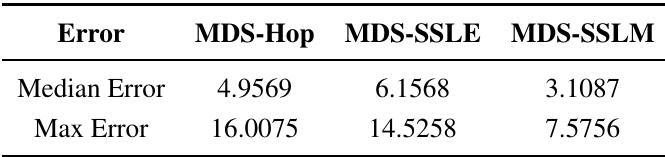
Table 1. Error statistics for a zonal network.